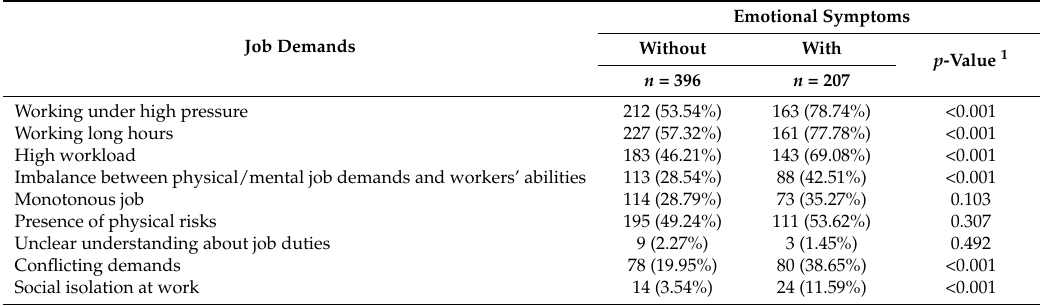
Table 2. Distribution of job demands for emotional symptoms according to job